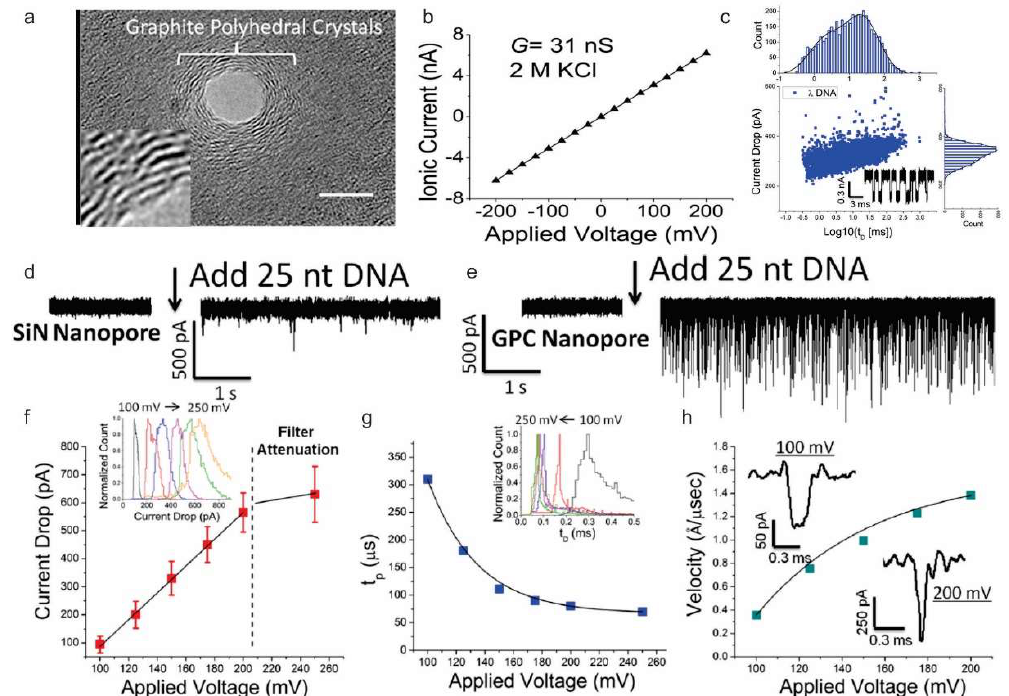
Figure 4. ( a ) Transmission electron microscopy image of the shrunked nanopore with graphite polyhedral crystal (GPC)-edges sculpted by the irradiation of electron beam (6.2 × 10 5 electrons/nm 2 · s) on to the single layer graphene. Scale bar = 5 nm. ( b ) Current versus voltage plot for a 5 nm nanopore (in diameter) having GPC-edges in the 2M KCl condition. ( c ) Current drop translocation time scatter plot for double stranded λ -DNA (5 nM concentration, 48.5 kb long) using a 5 nm nanopore with a GPC-edges at 250 mV [1 M KCl, 10 mM Tris, 1 M ethylenediaminetetraacetic acid (EDTA)]. The mean current drop value was 332 ± 62 pA by the scatter plot. ( d – e ) Ionic current traces for single-stranded DNA (25 bases in length) in ( d ) a 5 nm silicon nitride nanopores (50 nm thick) and ( e ) 5 nm graphene nanopores with GPC-edges. ( f – h ) Detailed characterization of 5 nm graphene nanopores with GPC-edges for 25 nucleotide-long DNA fragment sensing. ( f ) The linear increase in current drop based on applied voltages, ( g ) The exponential decrease of peak translocation time based on applied voltages, and ( h ) Calculated translocation velocity from ( e ). The velocity of the 25 nucleotide-long DNA fragment in 5 nm graphene nanopores with GPC-edges was 0.35 Å/ µ s at 100 mV/room temperature, which demonstrates the slower velocity than the silicon nitride pores. Events were recorded at 100, 125, 150, 175, 200, and 250 mV in 2 M KCl, 10 mM Tris (pH 8), 1 mM EDTA and 10 nM DNA at room temperature. Reproduced from Reference [74] with permission from the American Chemical Society.